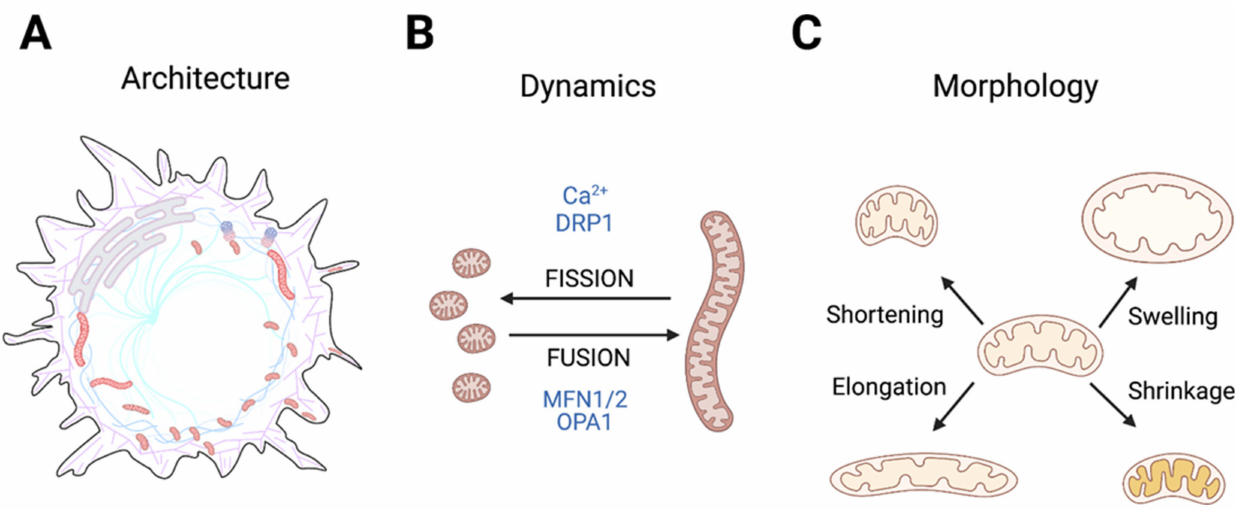
Figure 1. Schematic representation of the concepts of mitochondrial architecture ( A ), mitochondrial dynamics ( B ), and morphology ( C ) as used through this review. ( A ) Mitochondrial architecture refers to the positioning and interactions of the mitochondrial network and individual mitochondria with other cellular structures, such as the cytoskeleton and other membranes. ( B ) Mitochondrial dynamics encompasses the processes of fusion and fission. Finally, mitochondria morphology ( C ) refers to swelling, shrinking, elongation, and cristae reorganization, without fusion or fission events. All figures in this review have been created using